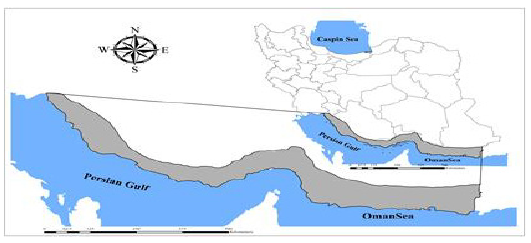
Figure 1. Location of the study area in